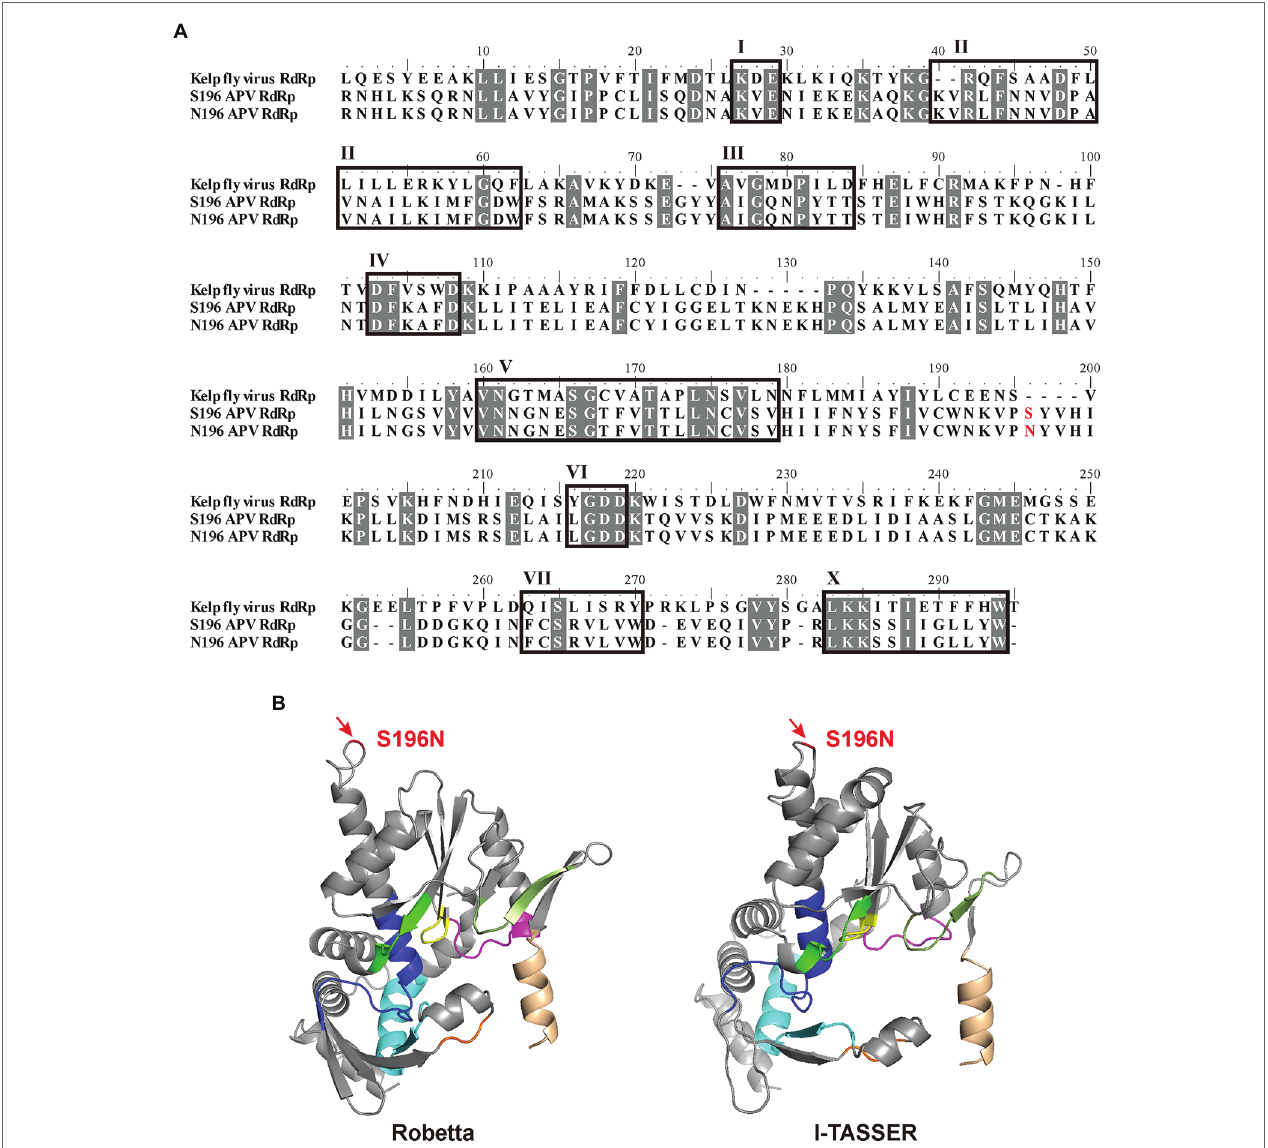
FIGURE 3 | Location of site 5,990 in the structure of RdRp. (A) Alignment of amino acid sequences among two types of APV RdRp and Kelp fly virus RdRp. Eight conserved motifs (I–VII, X) are boxed. The S or N at amino acid residue 196 is shown in red. Identical or similar amino acid residues among the three sequences are shaded in gray. (B) Three-dimensional structures of APV RdRp predicted in silico by the Robetta and I-TASSER servers. Motifs are shown in assorted colors: I, orange; II, cyan; III, magenta; IV, green; V, blue; VI, yellow; VII, smudge; X, wheat. Site S196N is marked in